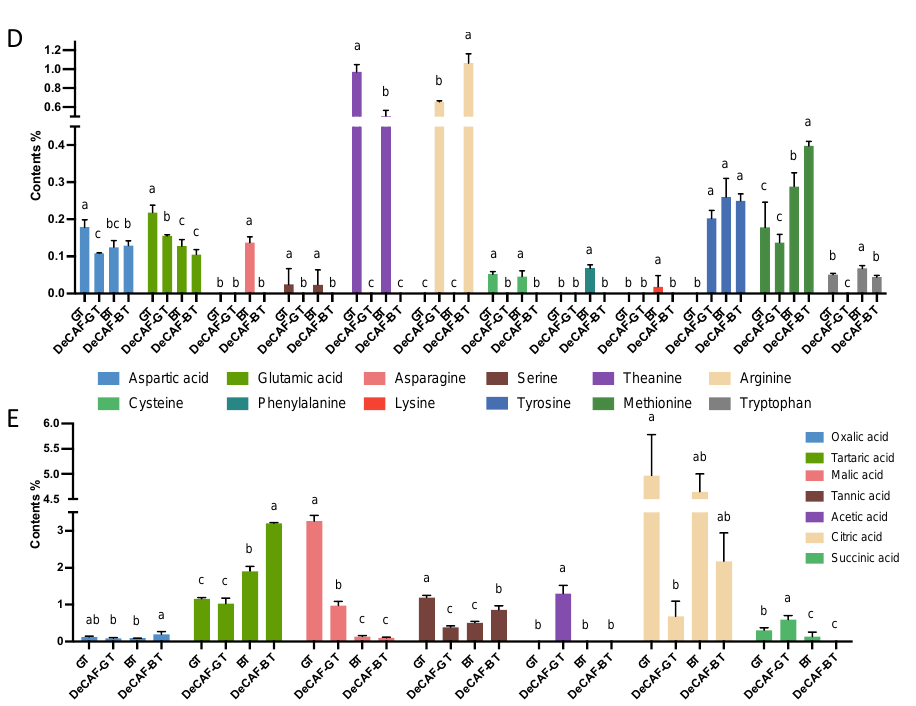
Figure 2. Contents of ( A ) total theaflavins, thearubigins, and theabrownins; ( B ) theaflavins, ( C ) catechins, ( D ) amino acids, and ( E ) organic acids of the green tea (GT), decaffeinated green tea (DeCAF-GT), black tea (BT), and decaffeinated black tea (DeCAF-BT). Abbreviations: theaflavins (TF); theaflavin-3-gallate (TF-3G); theaflavin 3’-O-gallate (TF-3’-G); theaflavin 3,3’-digallate (TFDG); epigallocatechin gallate (EGCG); gallocatechin (GC); epigallocatechin (EGC); catechin ( C ); epicatechin (EC); gallocatechin gallate (GCG); epicatechin gallate (ECG); gallic acid (GA). Different letters for the same component indicate significant differences ( p < 0.05).